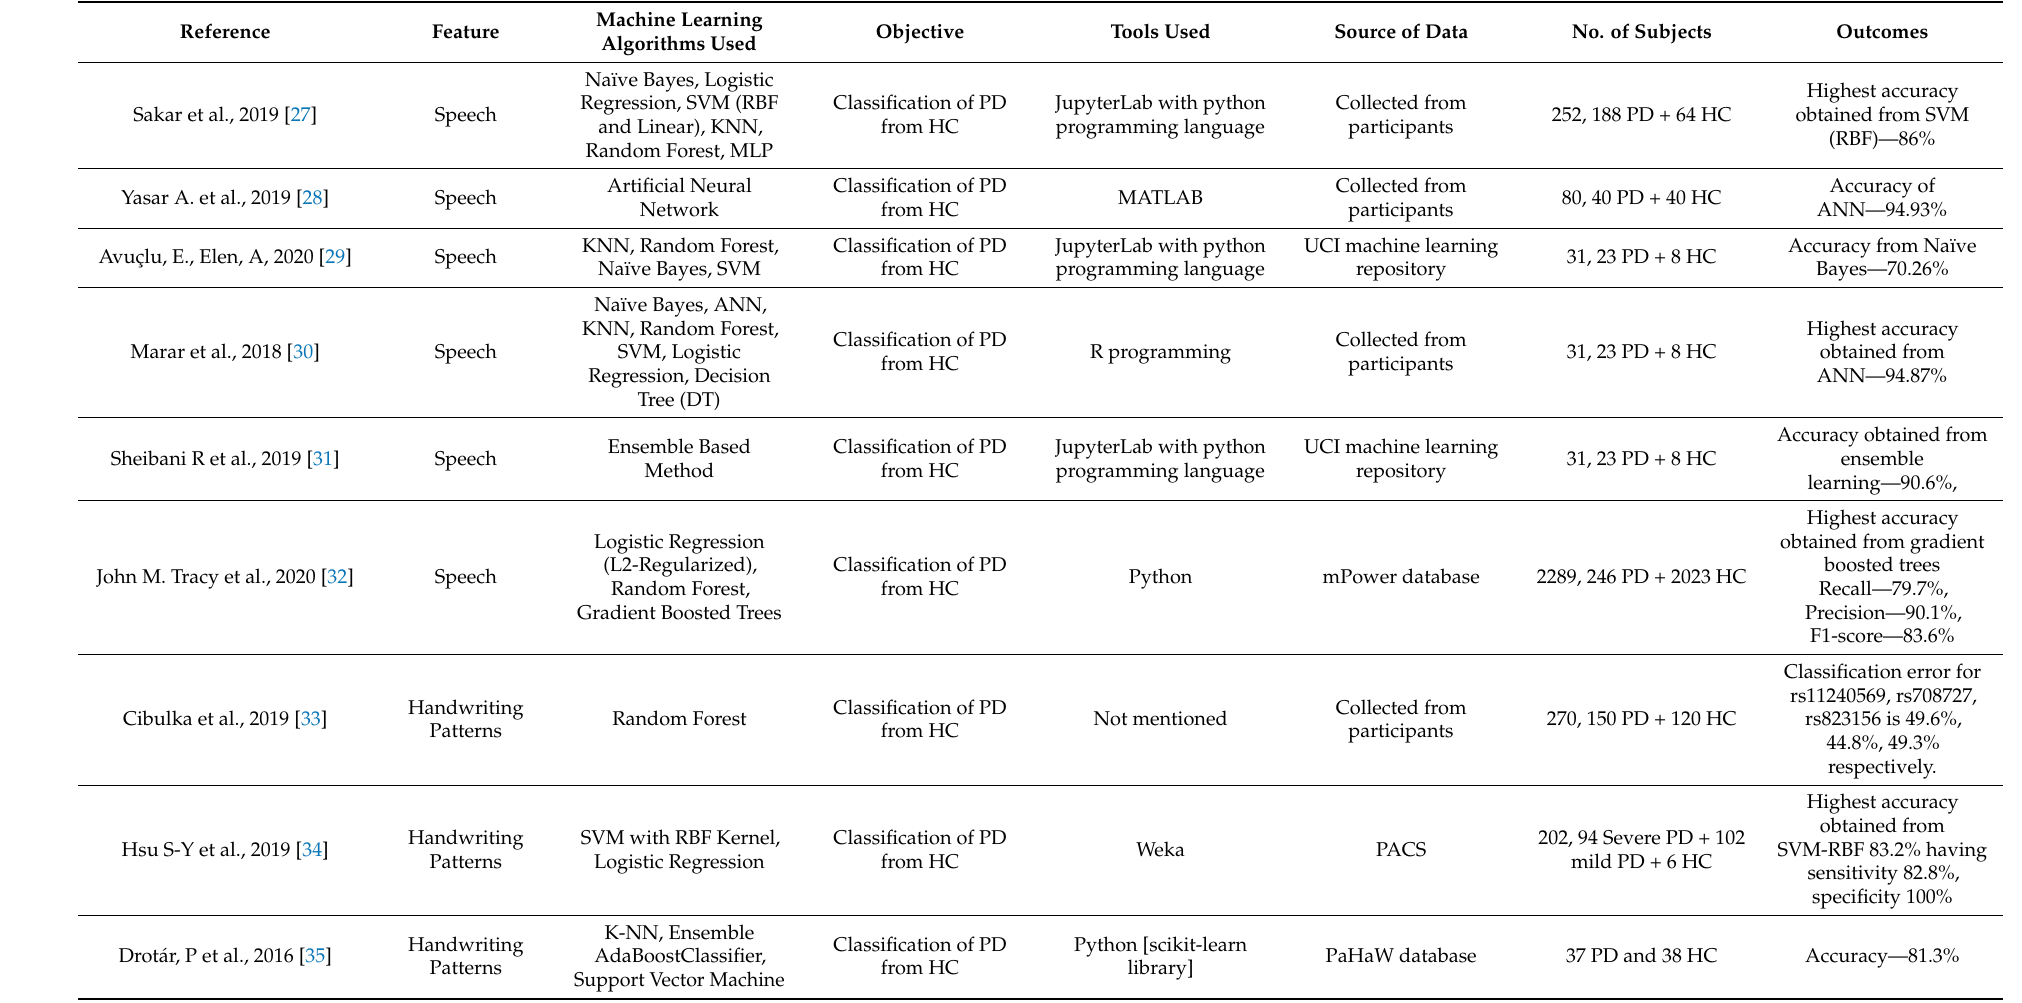
Table 1. Comparative Studies of Machine Learning Approaches to diagnose Parkinson’s